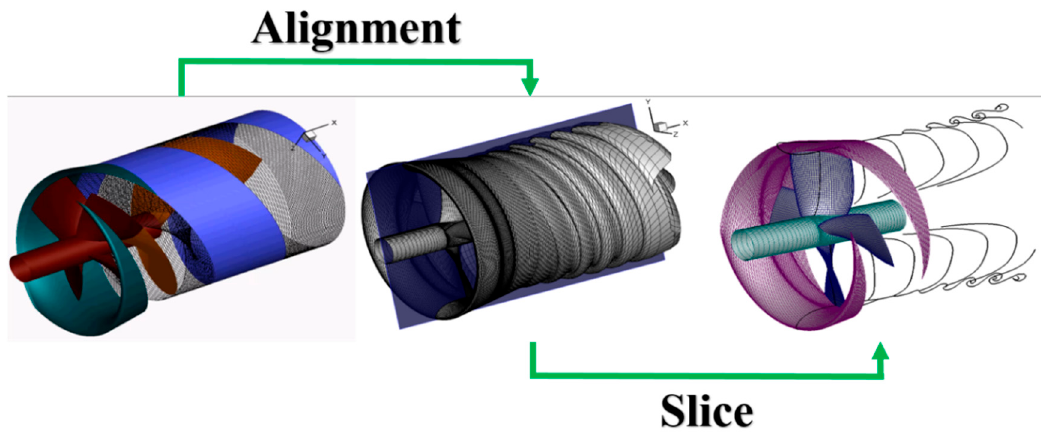
Figure 12. Perspective views of initial ( left ), and fully aligned duct wake shape ( middle ), predicted by the present method, and intersection of the duct wake shape with a (cid:1876) – (cid:1877) plane passing through the propeller axis ( right ).